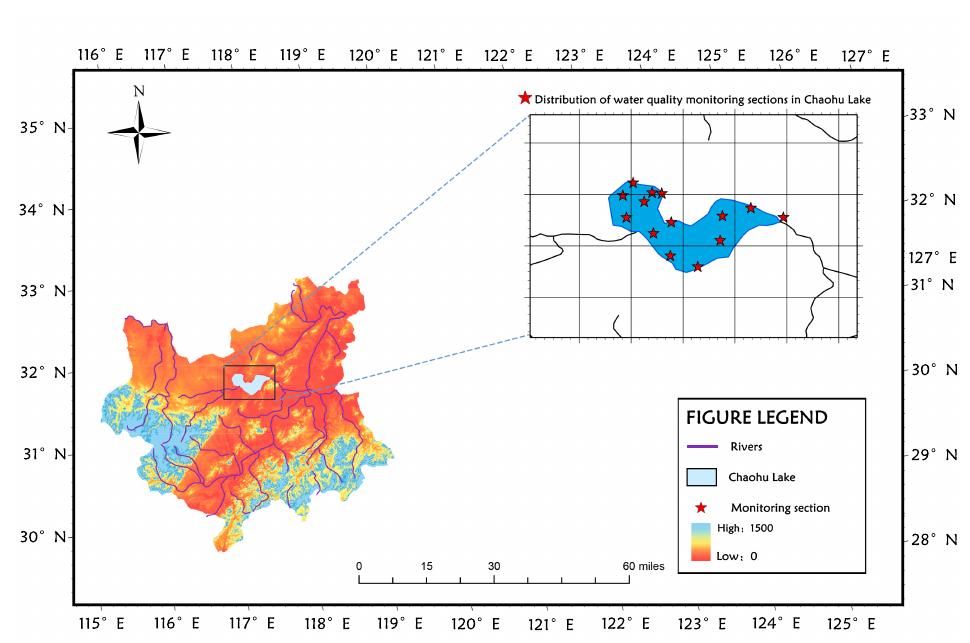
Figure 2. Distribution of water quality monitoring section points in Chaohu